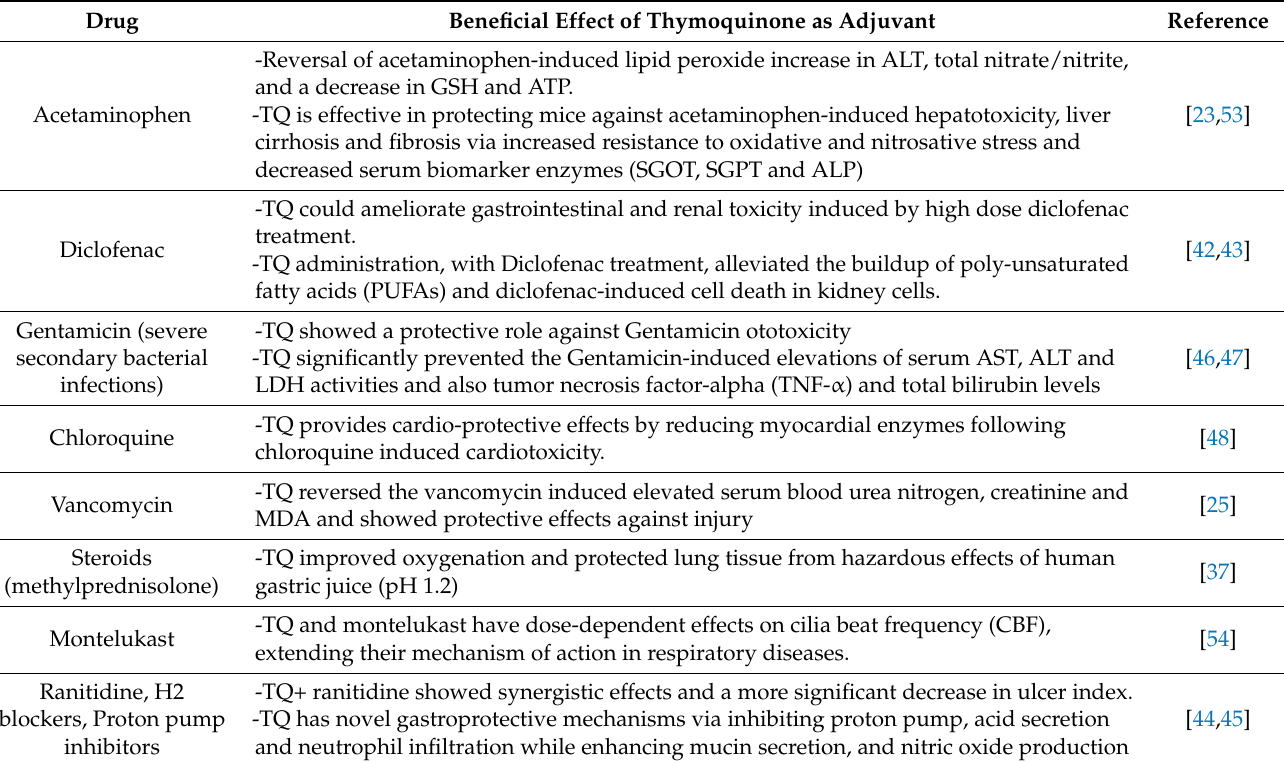
Table 2. Thymoquinone (TQ) as a potential adjuvant therapy to minimize SARS-CoV-2(severe acute respiratory syndrome- coronavirus-2) treatments’ side